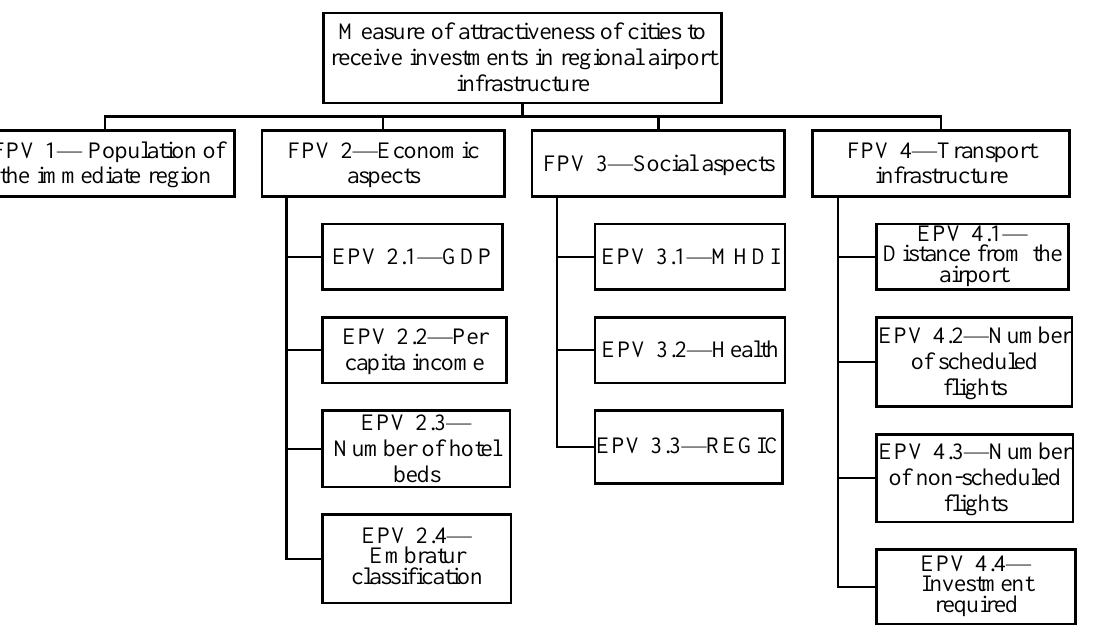
Figure 2. Tree of points of view (Source: [43]).